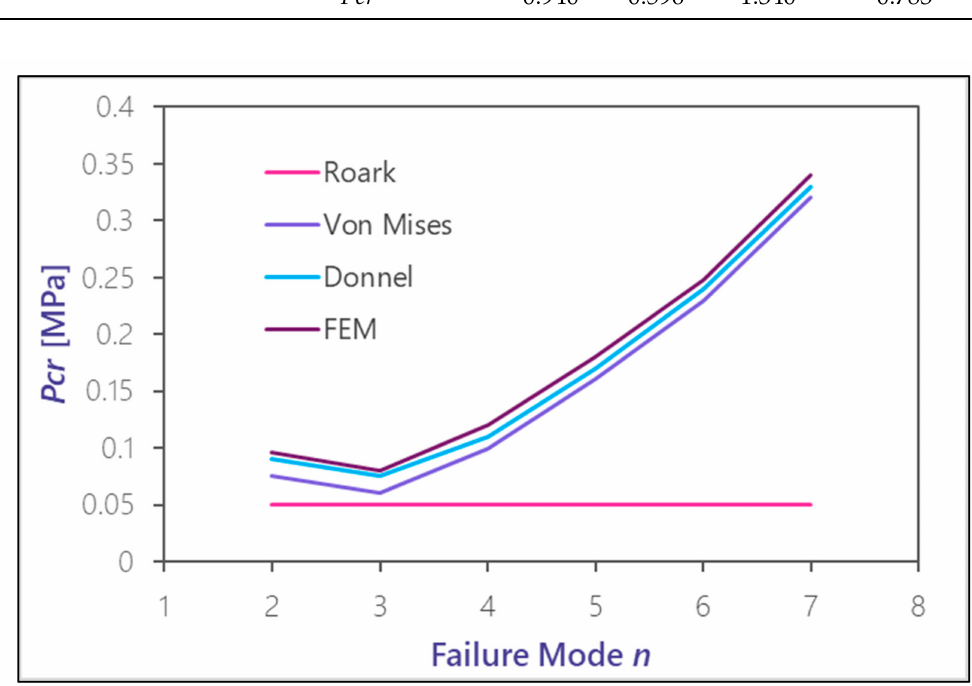
Figure 8. Comparison of the calculated critical buckling pressure without consideration of radial constraint; D / t = 285.7 and L = 30